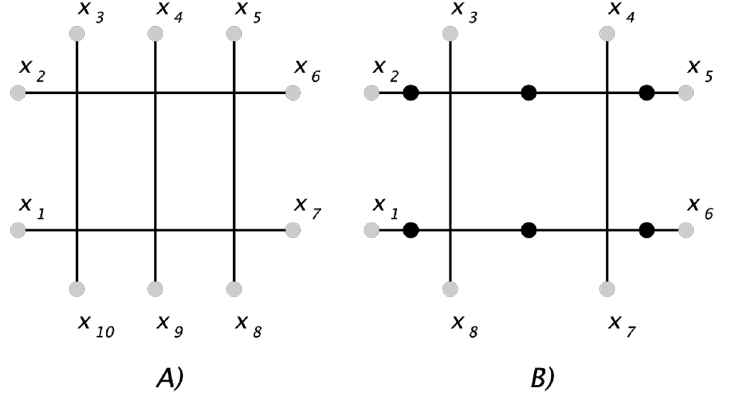
( x ) φ ( x ) . . . φ ( x )) i in the D = 4 , ω = 1 model. 1 1 1 2 2 10 and φ fields are identical in this case. B) graph corresponds to the only 1 2 ) χ ( x ) . . . φ ( x )) i in the D = 6 , 1 2 8